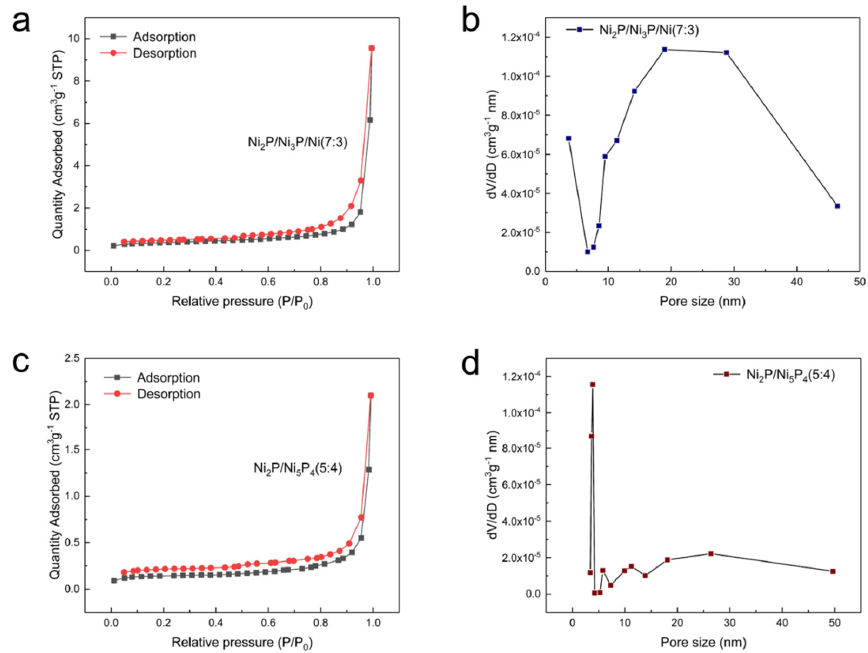
Figure 4. The BET test and pore size distribution information. ( a , c ) The BET test information of Ni 2 P/Ni 3 P/Ni (Ni/P = 7:3) and Ni 2 P/Ni 5 P 4 (Ni/P = 5:4). ( b , d ) The pore size distribution information of Ni 2 P/Ni 3 P/Ni (Ni/P = 7:3) and Ni 2 P/Ni 5 P 4 (Ni/P = 5:4).